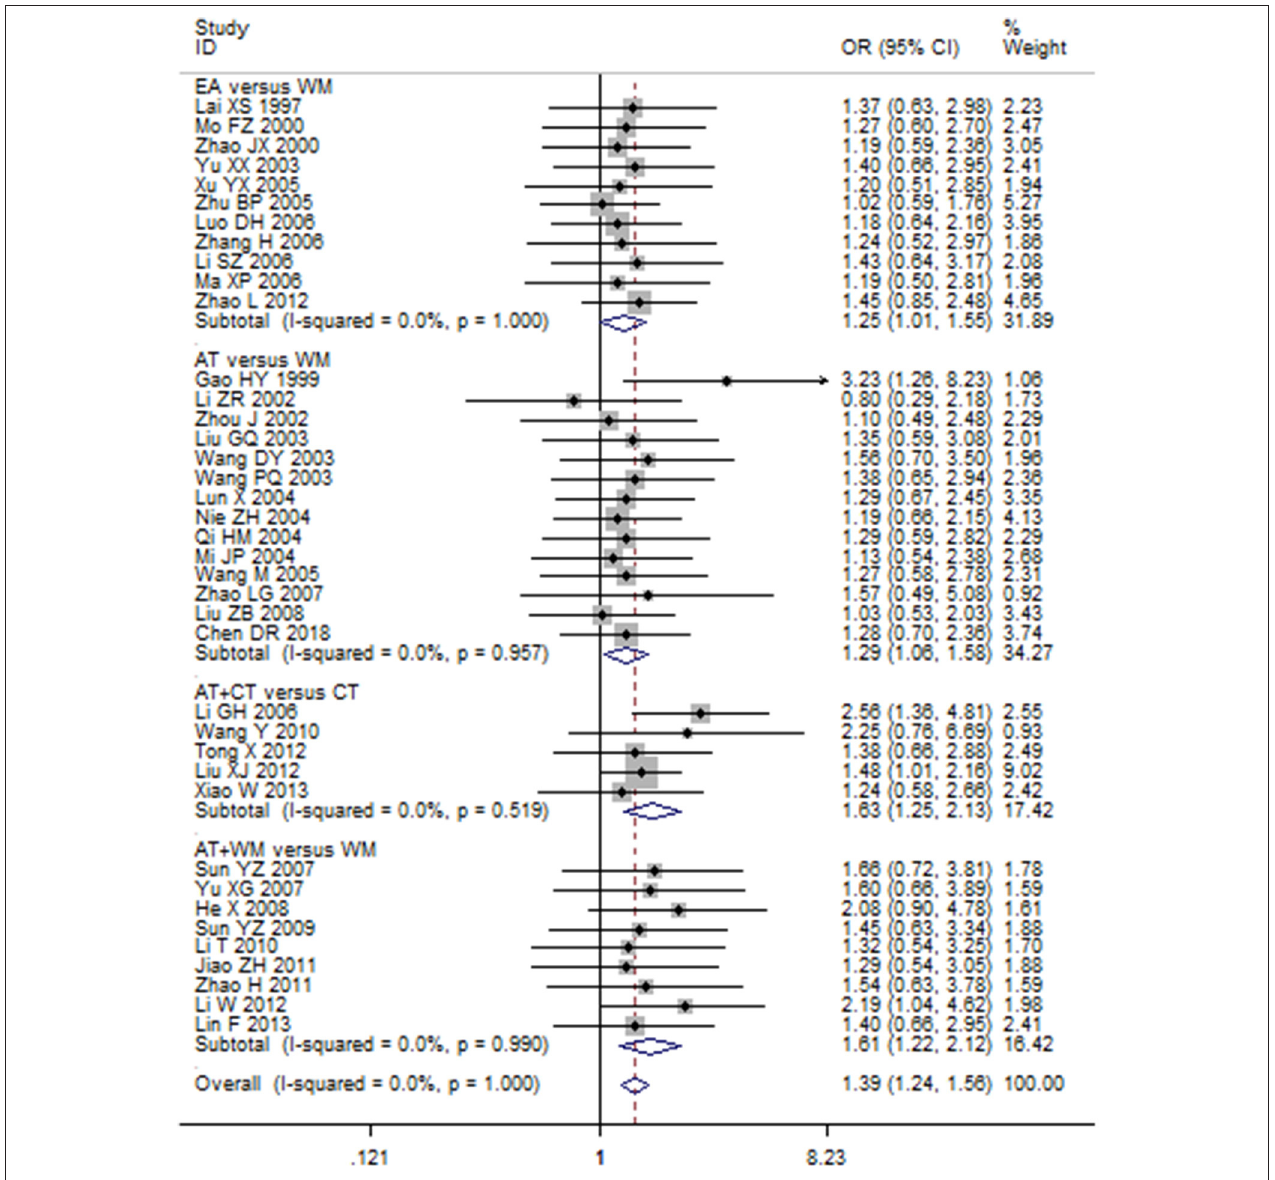
FIGURE 4 | Forest plot of the effect of acupuncture on the clinical efficacy using fixed